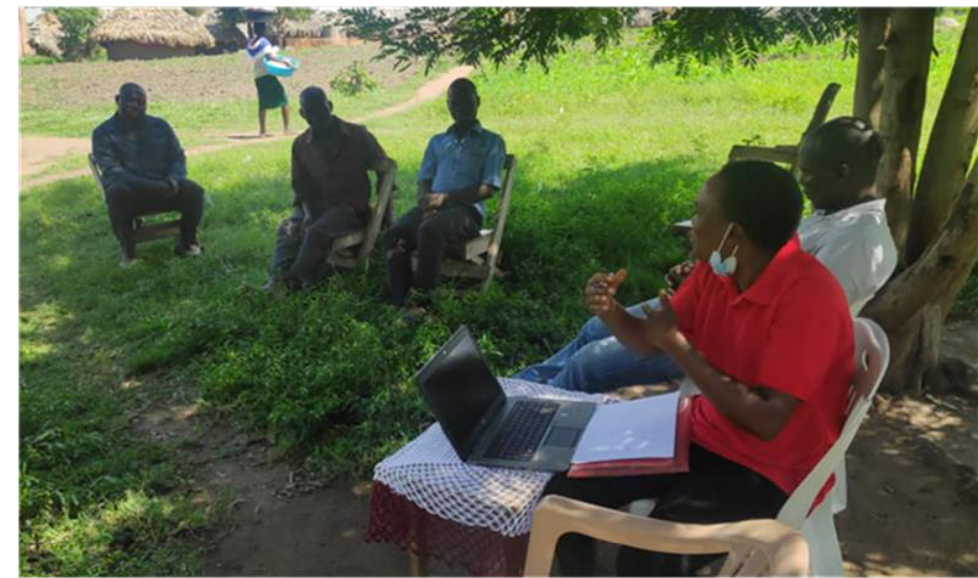
Figure 3. Focus group discussion at Iyingo fish landing site.